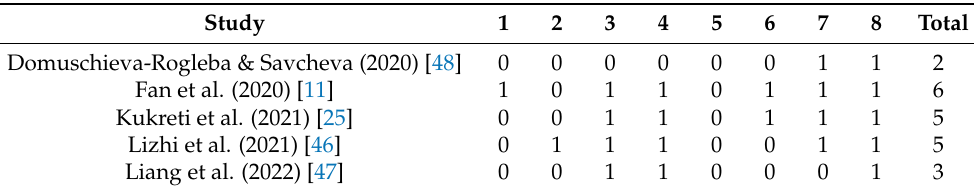
Figure 1. Flowchart of the study search and selection process. Table 2. Quality